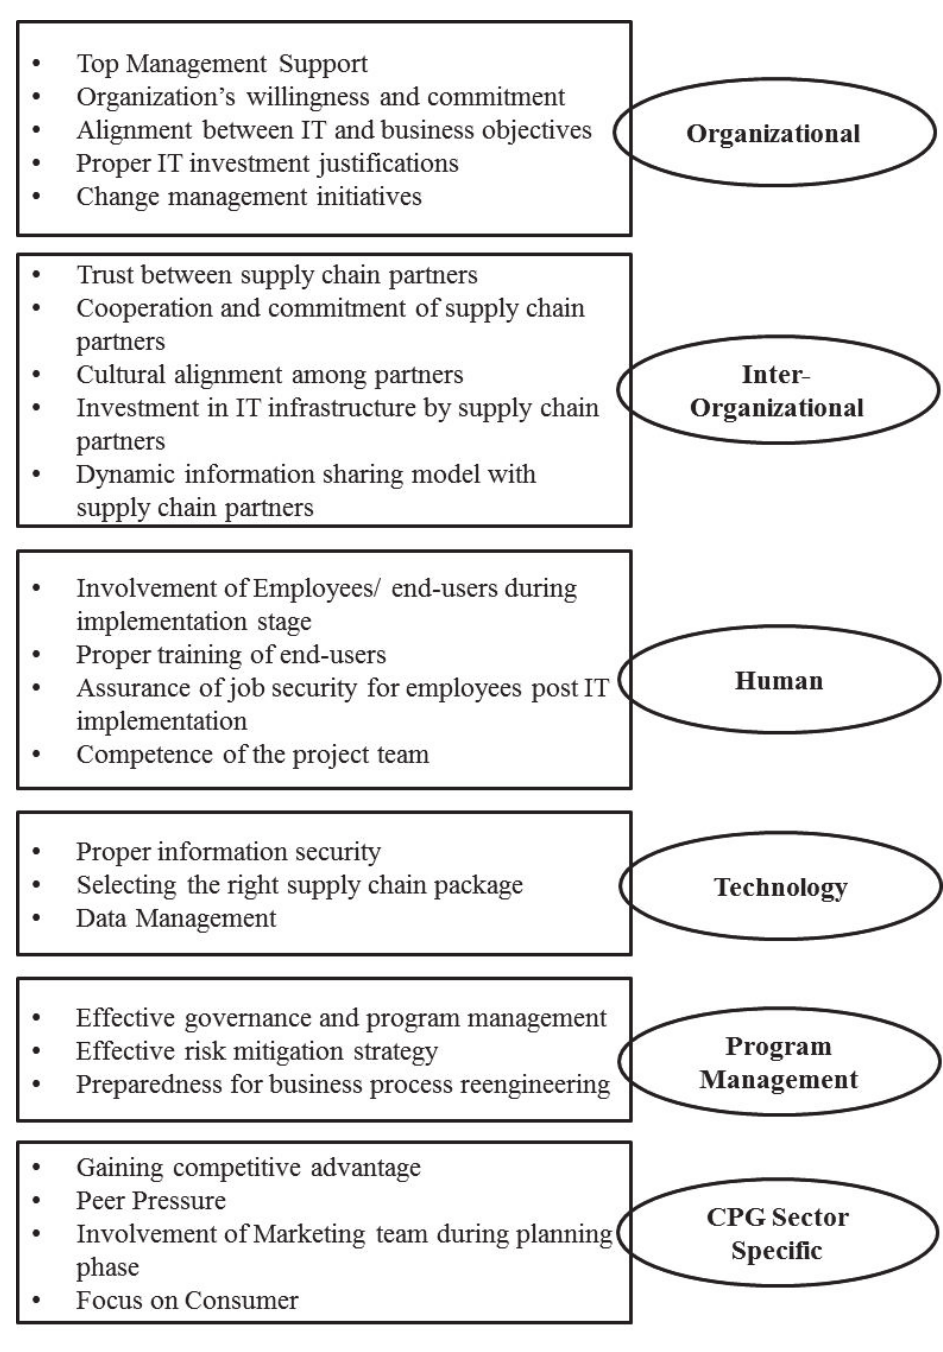
Fig. 2. Critical Success Factors (CSFs) post Factor